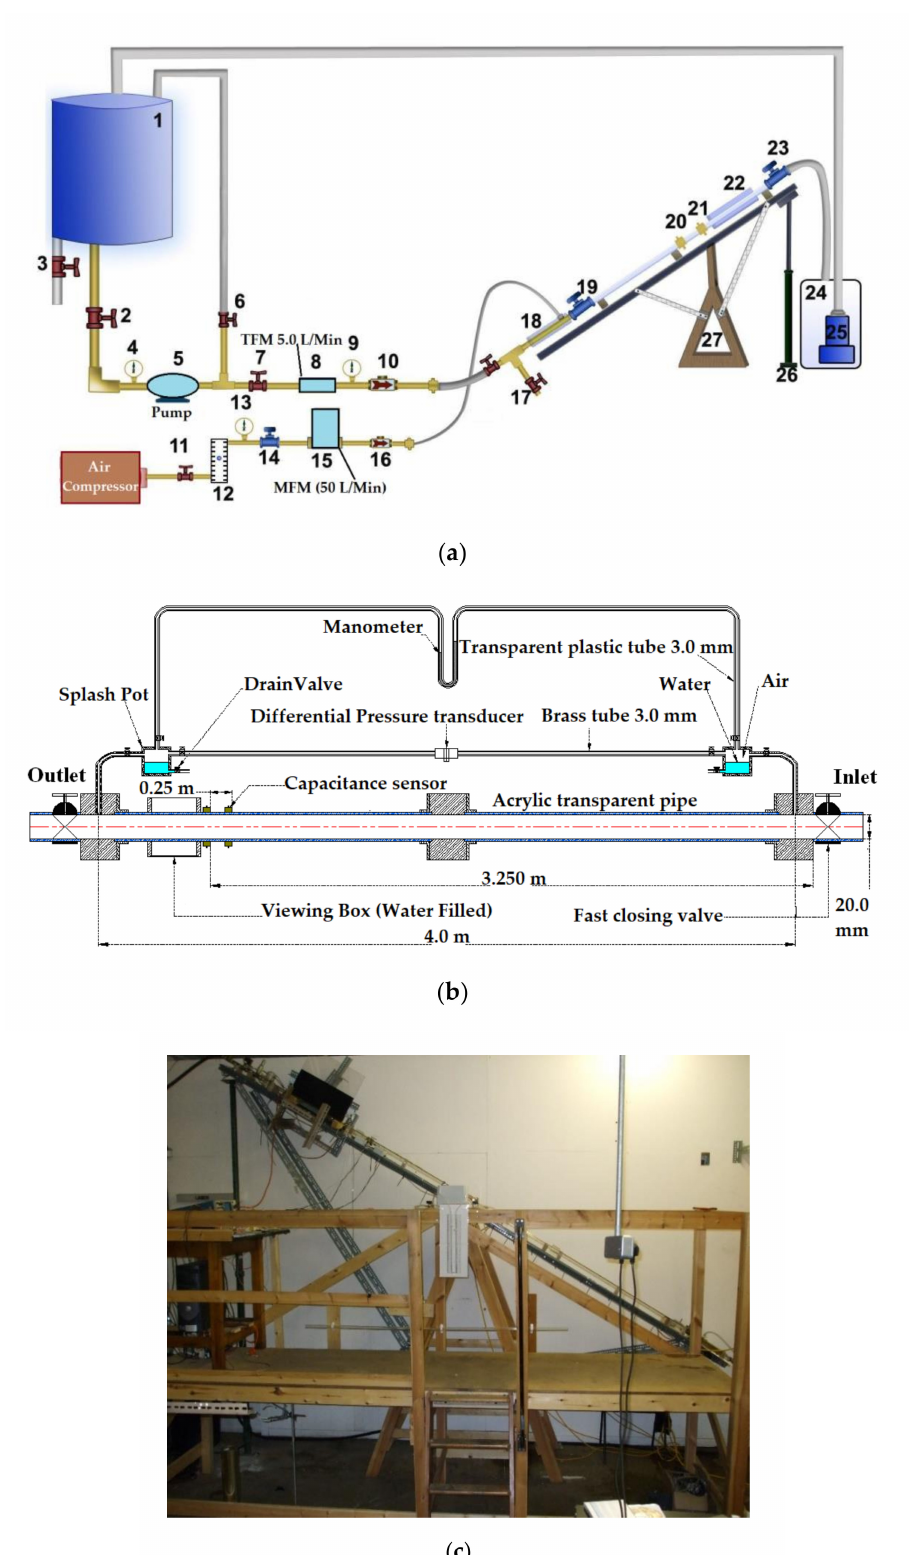
Figure 1. ( a ) Representation of the flow rig: (1) the water tank 1; (2), (6) and (7), the regulator valve; (3) and (17), the drain valves; (4) the temperature gauge; (5) the centrifugal pump; (8) the turbine flow meter; (9) and (13), the pressure gauges; (10) and (16), the check valves; (11) the pressure reducer; (12) the gas ball flow meter; (14), (19) and (23), the fast closing valves; (15) the mass flow meter; (18) the gas–liquid mixer; (20) and (21), the capacitance sensors; (22) the viewing box; (25) the submersible centrifugal pump; (24) the water tank 2; (26) the jack; (27) the swing table; ( b ) the diagram of the test section, and ( c ) the image of the actual experimental